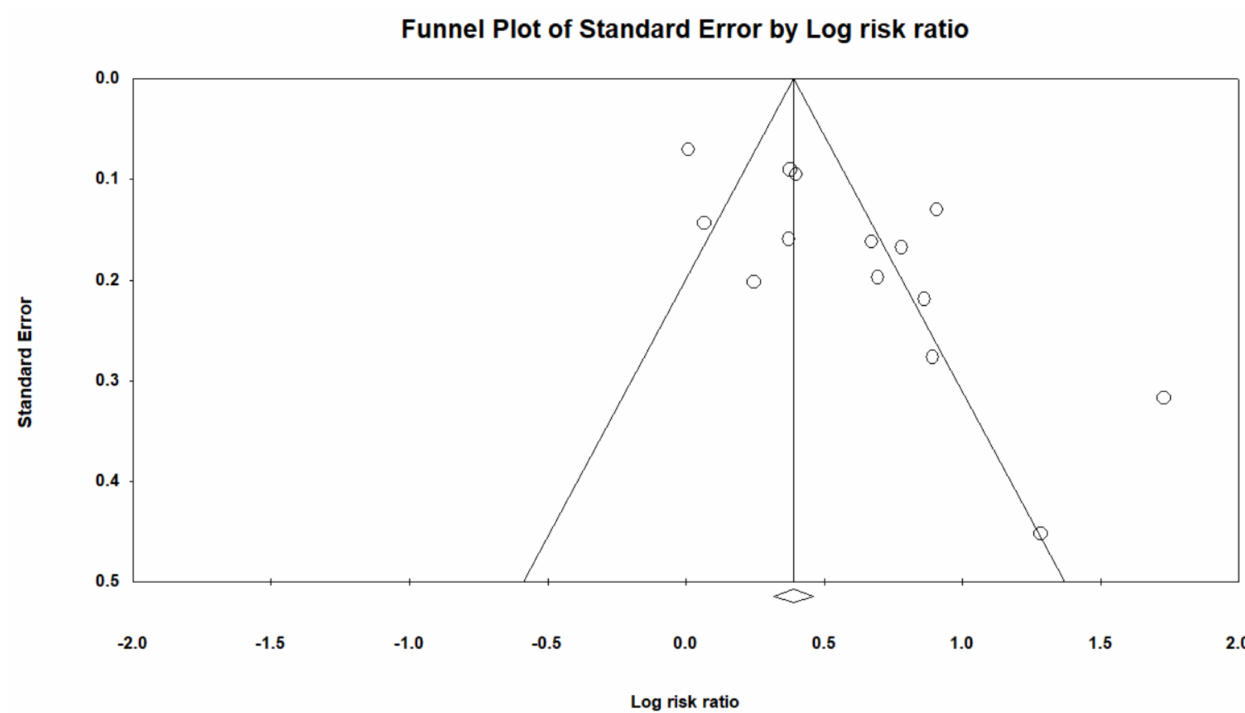
Figure 3. Funnel plot of the risk gastric cancer among patients with PPIs.